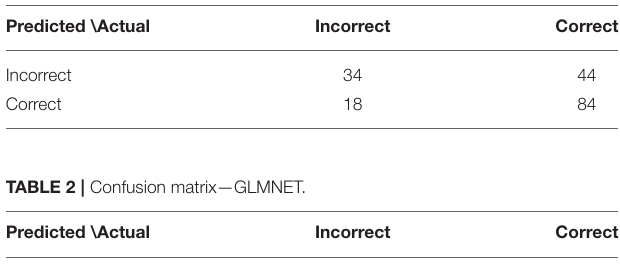
TABLE 1 | Confusion matrix—random forest.